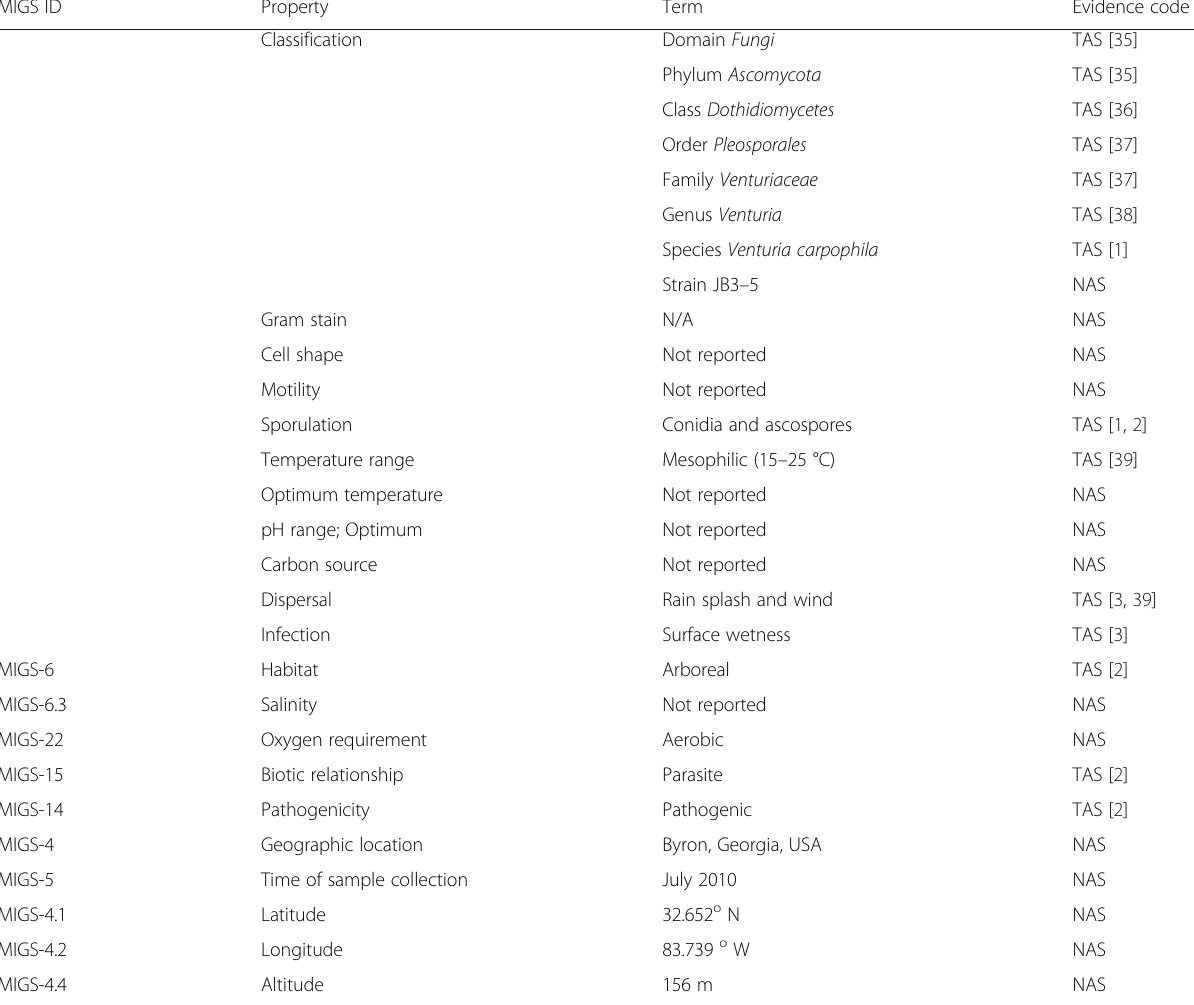
Table 1 Classification and general features of Venturia carpophila MIGS